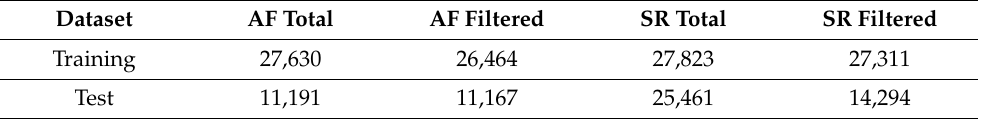
Table 2. The number of electrocardiogram segments with atrial fibrillation (AF) and sinus rhythm (SR) in training and test sets before and after discarding the segments with artifacts. Dataset AF Total AF Filtered